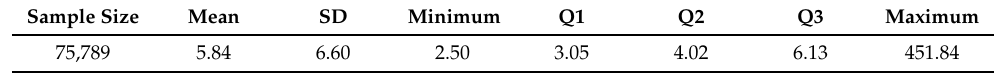
Table 6. Summary statistics for SOA group medical insurance claims, for 1991 (in 10,000 USD).